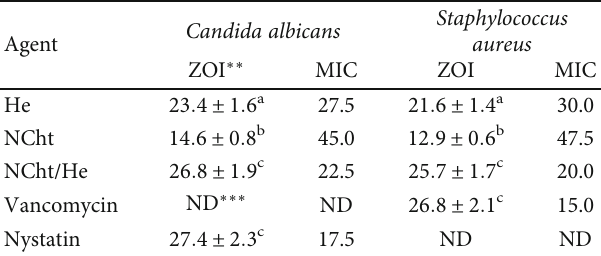
Figure 3: FTIR spectra of nanochitosan (Cht), henna extract (He), and their composites alone (Cht/He) and with collagen (Cht/He/Col). Table 1: Antimicrobial activity of synthesized agents against shin pathogens measured as zone of inhibition (ZOI, mm) ∗ and minimal inhibitory concentrations (MIC, μ